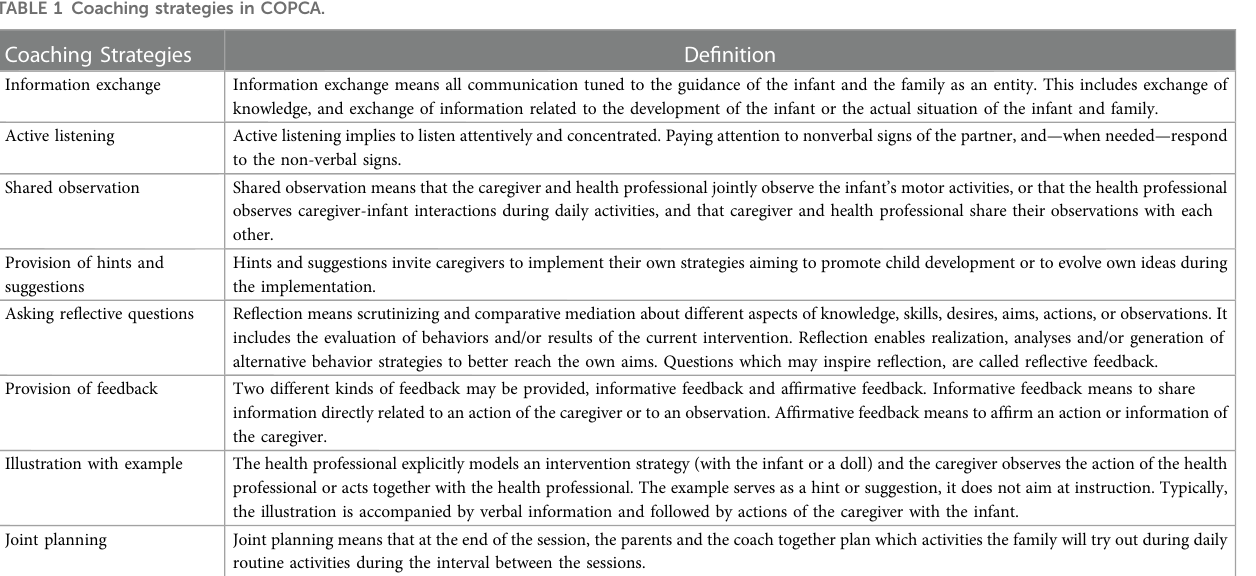
TABLE 1 Coaching strategies in